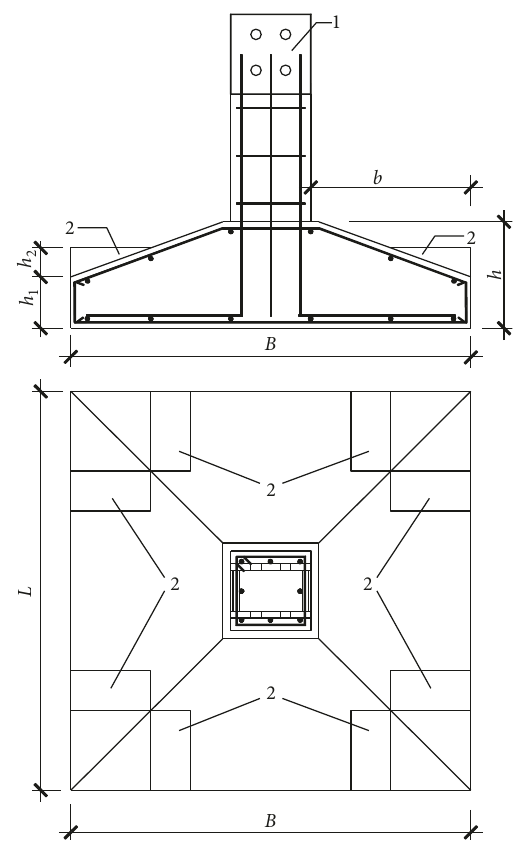
Figure 1: Configuration of